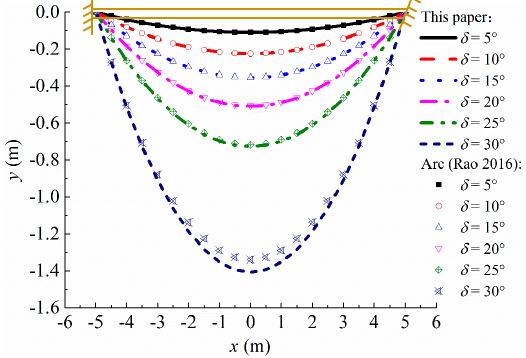
Figure 6. Comparison of minor principal stress trajectory.